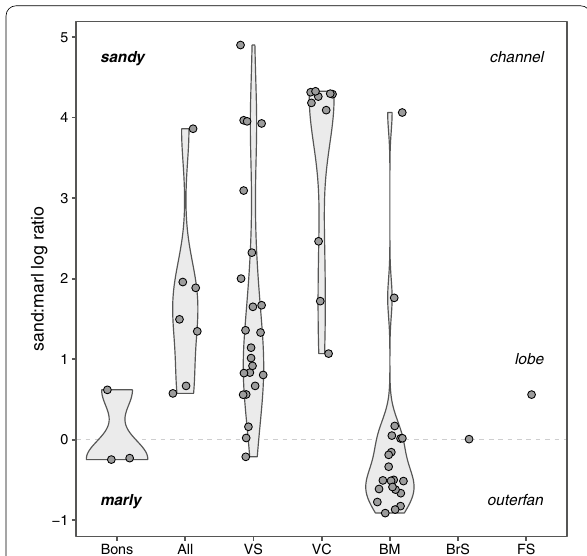
Fig. 7 Sand:marl ratio of several outcrops from the Voirons Flysch with approximate palaeo‑environmental interpretation. Dashed line corresponds to an equilibrium between marly interbeds and sandy beds. Note that the Bons Mb. (Bons) and the Boëge Marl (BM) share similar distributions. The Voirons Sandstone (VS) shows a widespread distribution from marl‑dominated to sandy outcrops. The Allinges Mb. (All) and the Vouan Conglomerate (VC) are exclusively dominated by sand, the former being less proximal than the latter. Finally, only one exposure with frequent marly interbeds (Fig. 13f) of the Bruant Sandstone (BrS) is here considered due to the chaotic bedding in this unit. The Fenalet Sandstone (FS) is restricted to the main outcrop